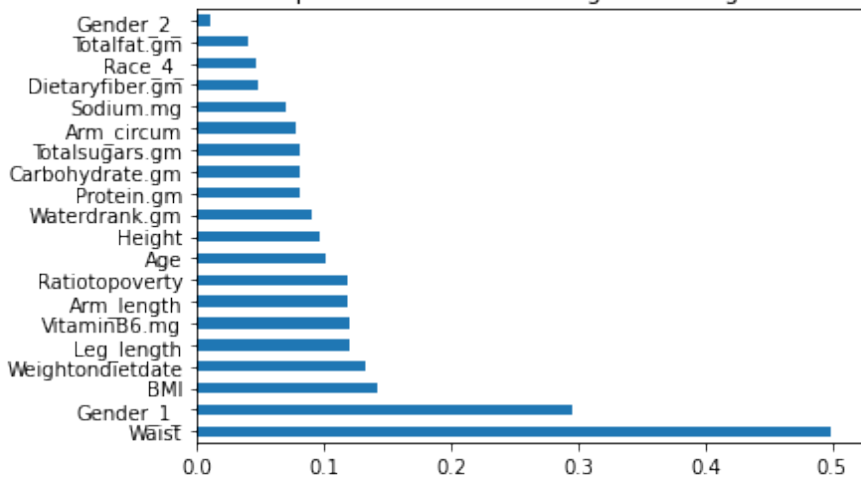
Figure 9. Most Important Features for Weighted Voting